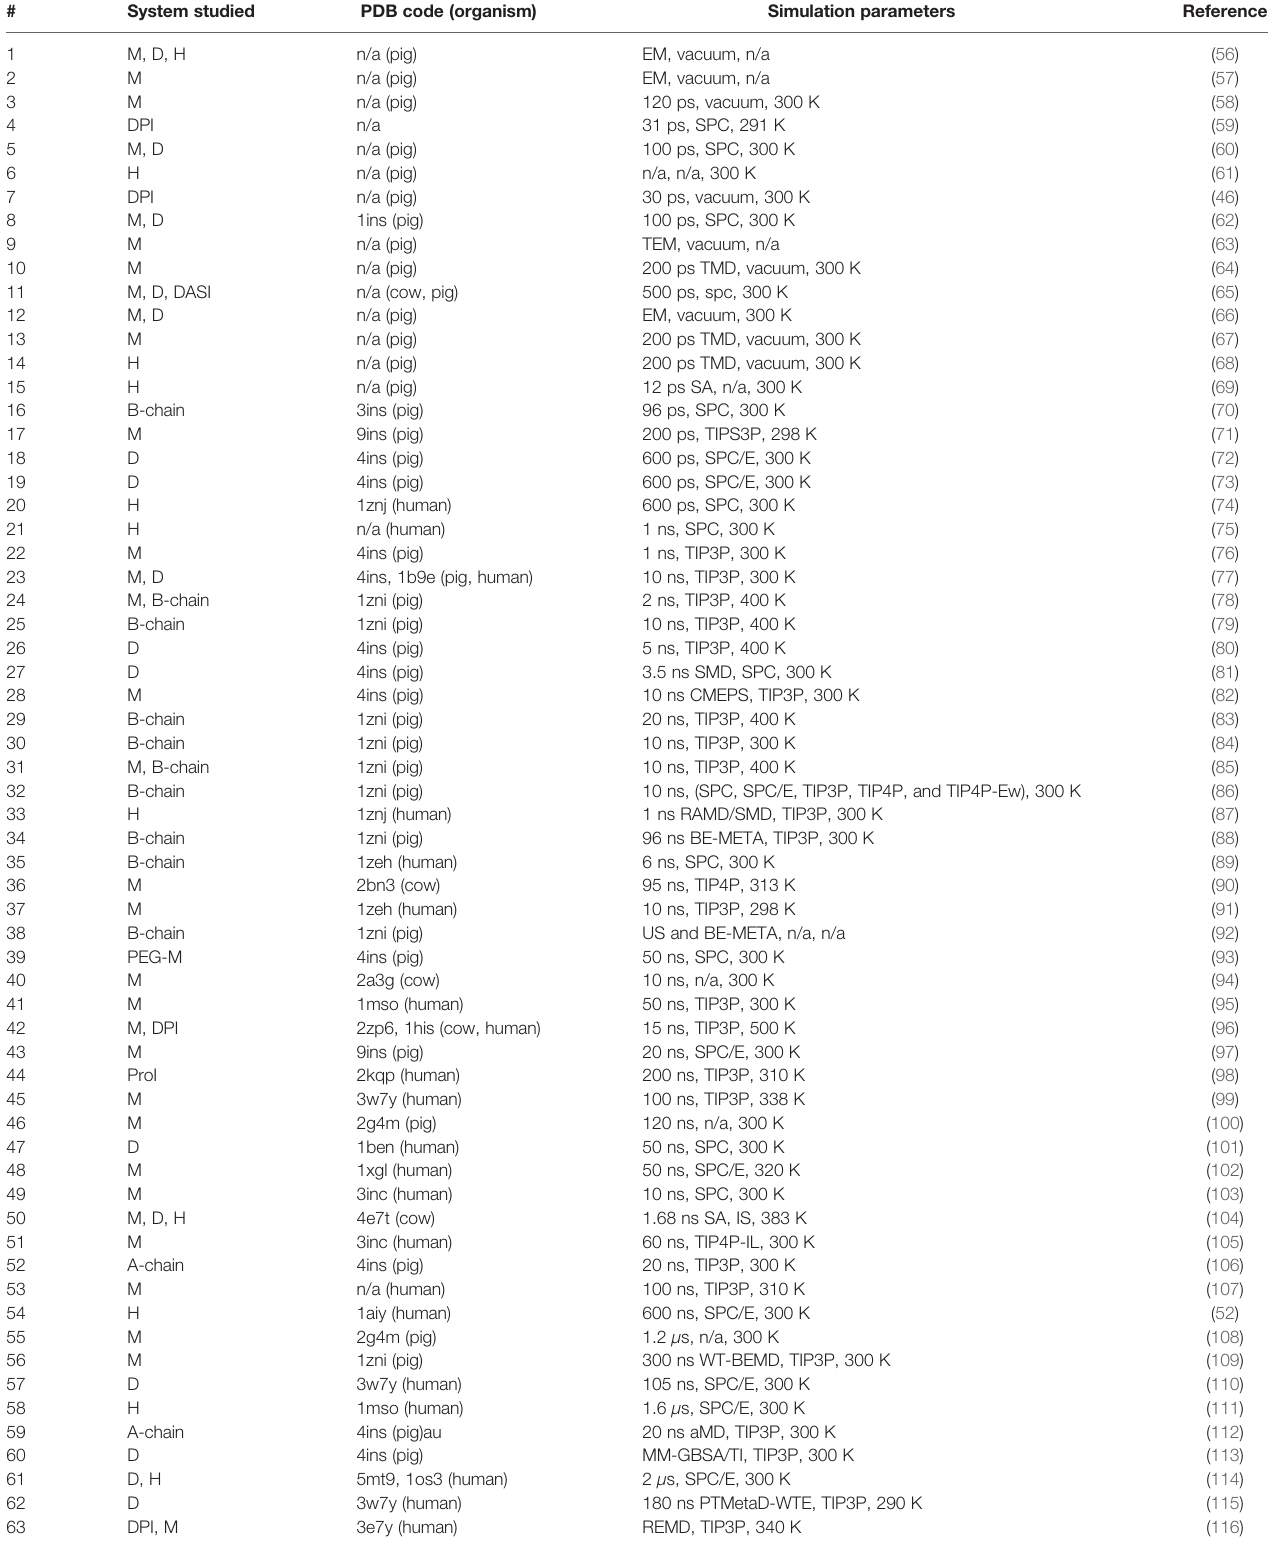
TABLE 1 | A chronological summary of simulation studies on different forms of the hormone insulin (M, monomer; D, dimer; and H, hexamer). # System